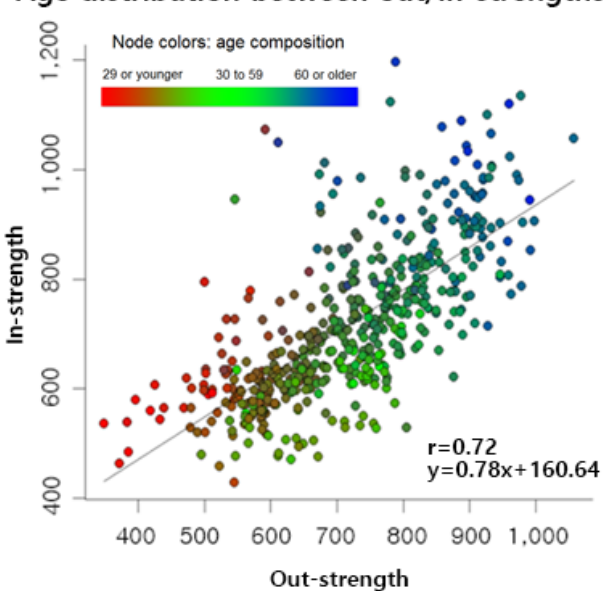
Figure 5. Out- and in-strengths plotted according to the age composition of the